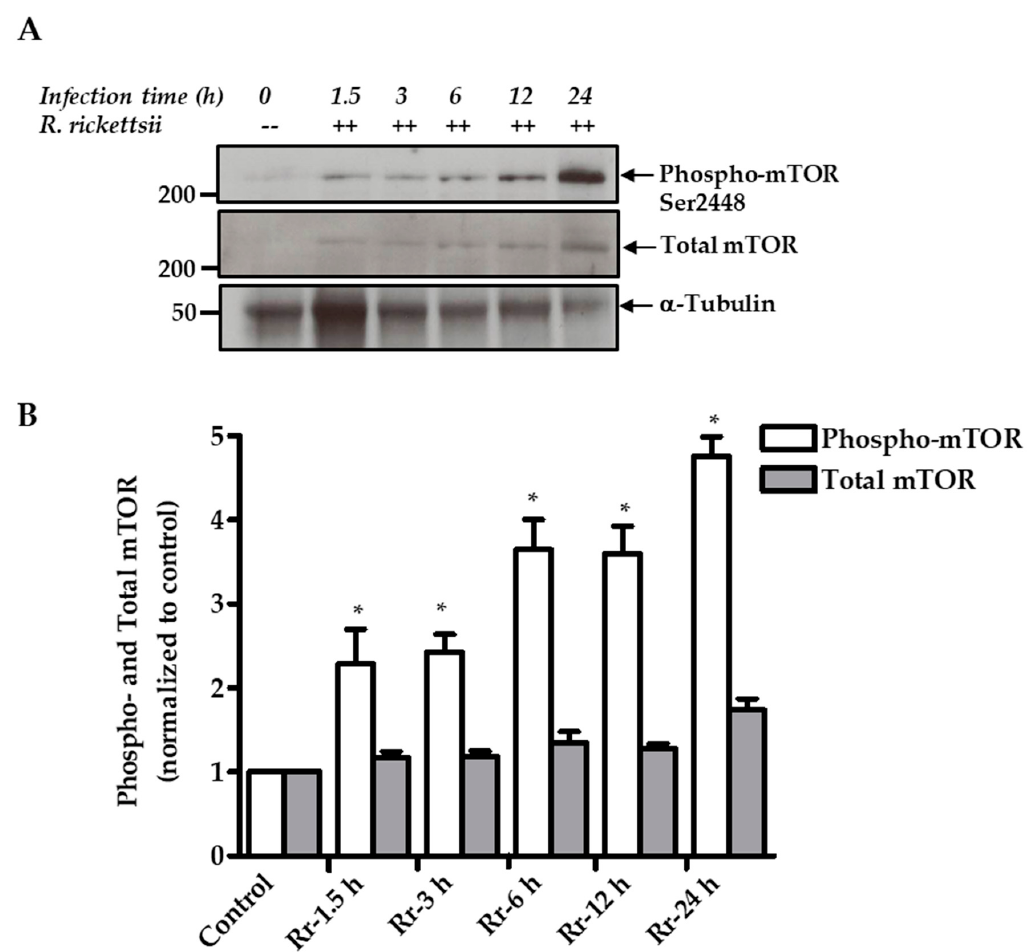
Figure 3. Mechanistic target of rapamycin (mTOR) phosphorylation in R. rickettsii -infected ECs. ( A ). Confluent HUVECs were either mock infected (–) or infected with R. rickettsii ( ++ ) at MOI of 5 PFUs / cell for various times as indicated. Total protein lysates from infected as well as corresponding mock-infected ECs were subjected to immunoblotting and probing with antibodies against phospho- and total mTOR. An antibody against α -tubulin was used to re-probe the blots after stripping to account for variations in sample loading on di ff erent lanes of the gel. Relative positions of nearest molecular weight marker (kDa) from the protein ladder are displayed on the left flank of the gel. Results from a representative blot ( n ≥ 3) are shown. ( B ). Quantitative densitometry analysis of the phospho- and total mTOR during R. rickettsii infection of ECs as a function of time. The values are presented as the mean ± SEM of a minimum of three independent experiments. The asterisk (*) indicates statistically significant changes ( p ≤ 0.05) in R. rickettsii -infected cells compared with the baseline values in the corresponding samples from uninfected ECs. Data are representative of three independent experiments.